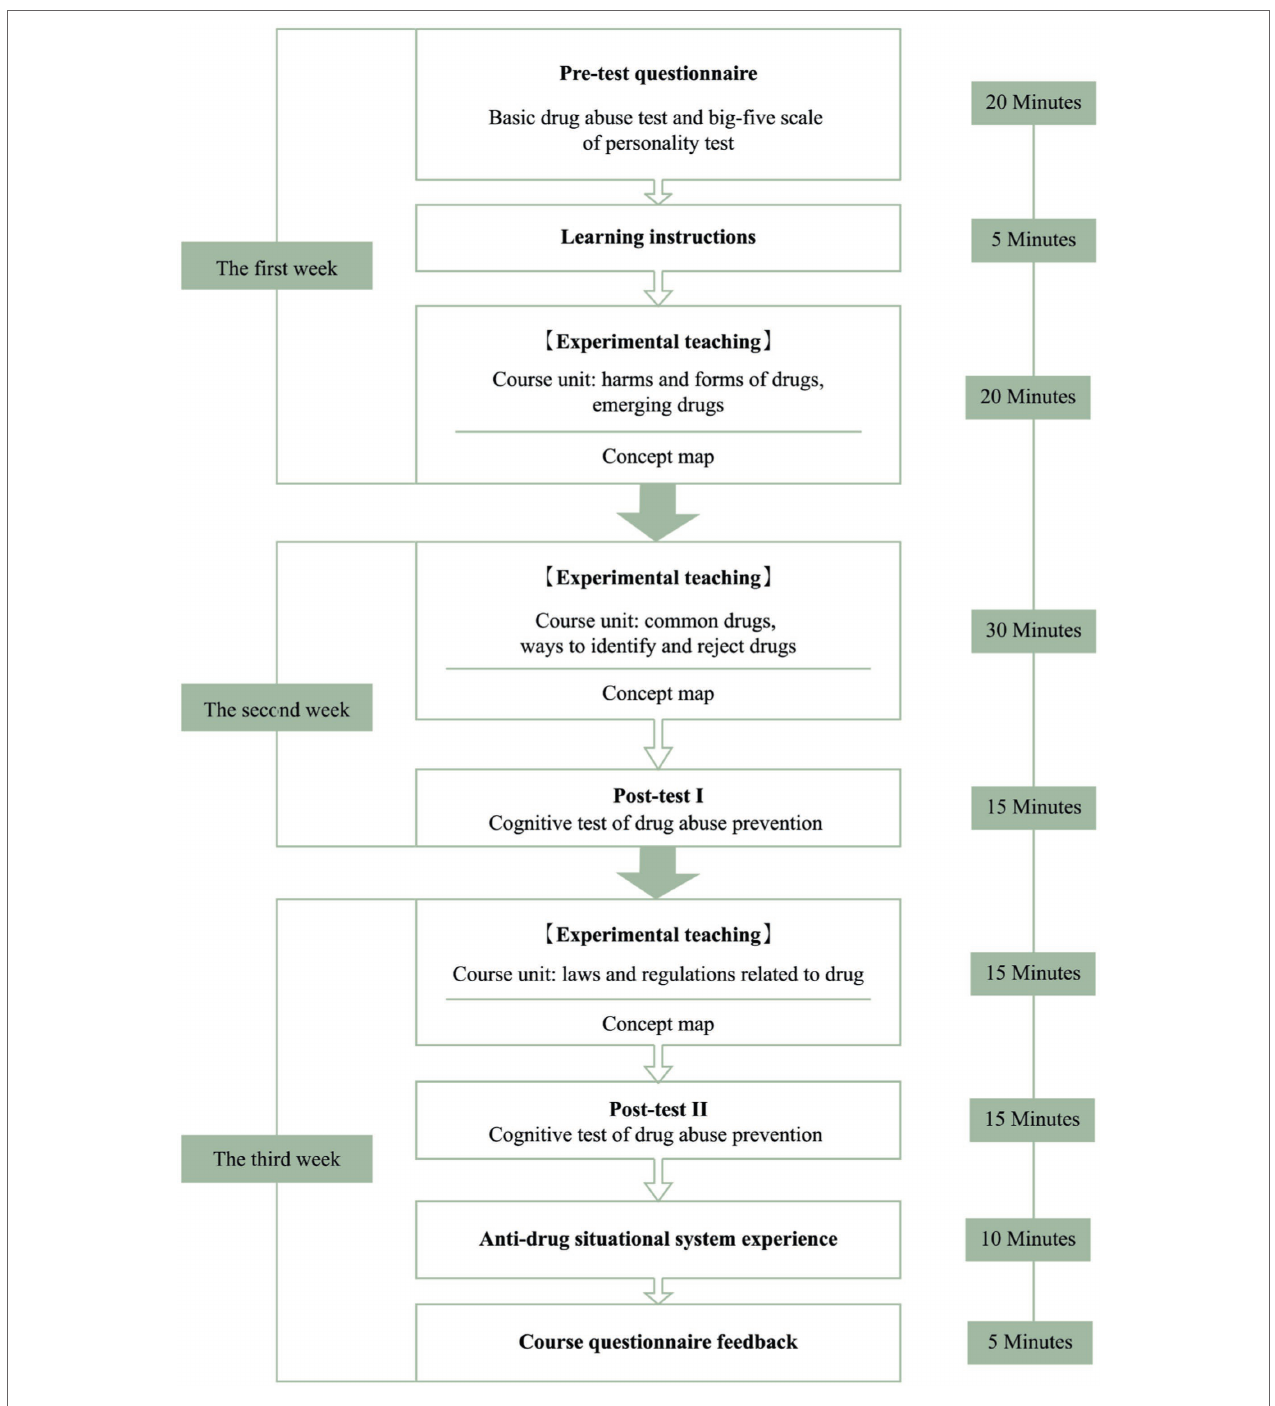
FIGURE 1 | Experimental flow